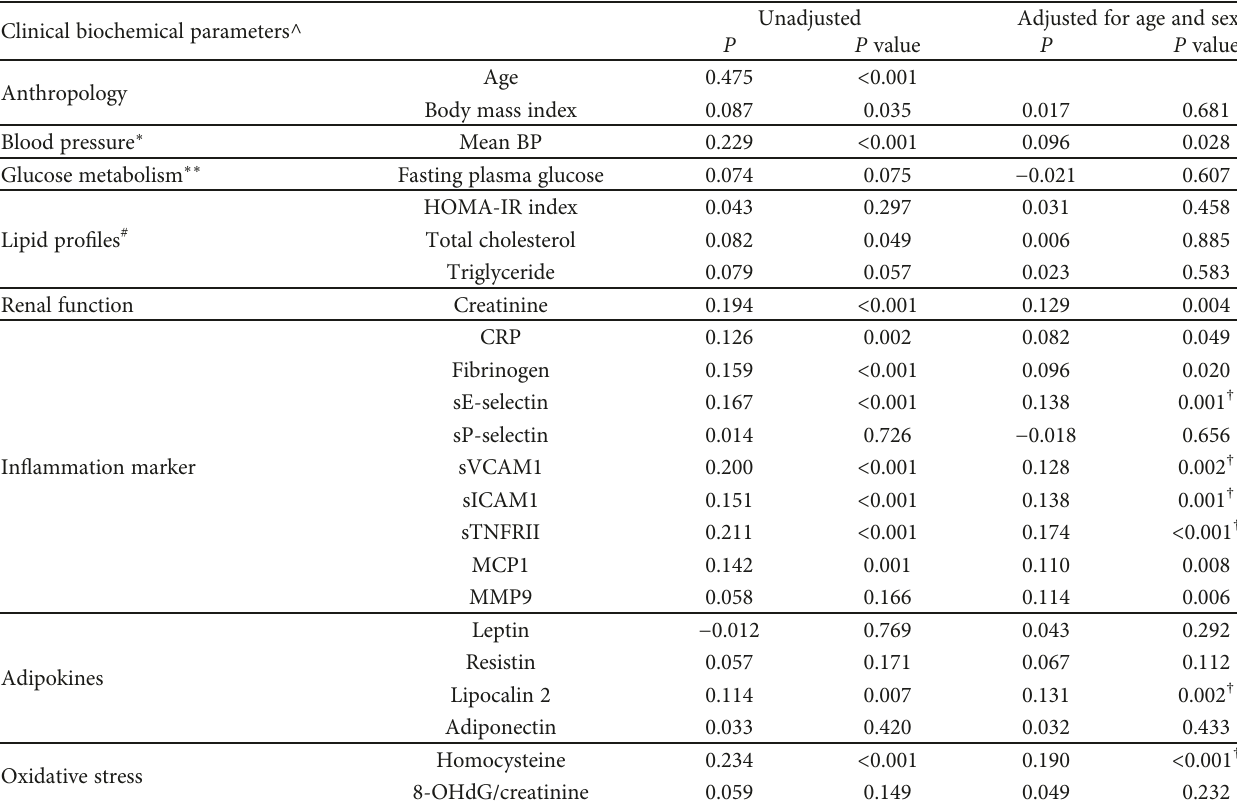
Table 4: Association between circulating growth di ff erentiation factor 15 (GDF15) levels and measurable cardiovascular risk factors in subjects from the healthy cohort. Clinical biochemical parameters^